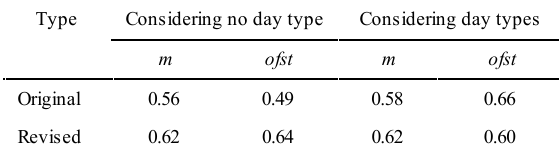
Table 3. Multiple Correlation Coefficients